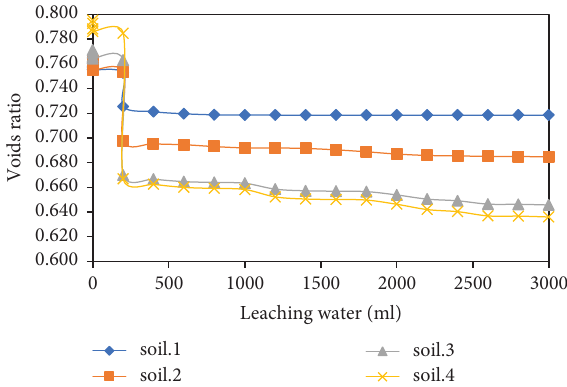
Figure 9: Te voids ratio with leachate water relationship for untreated soil